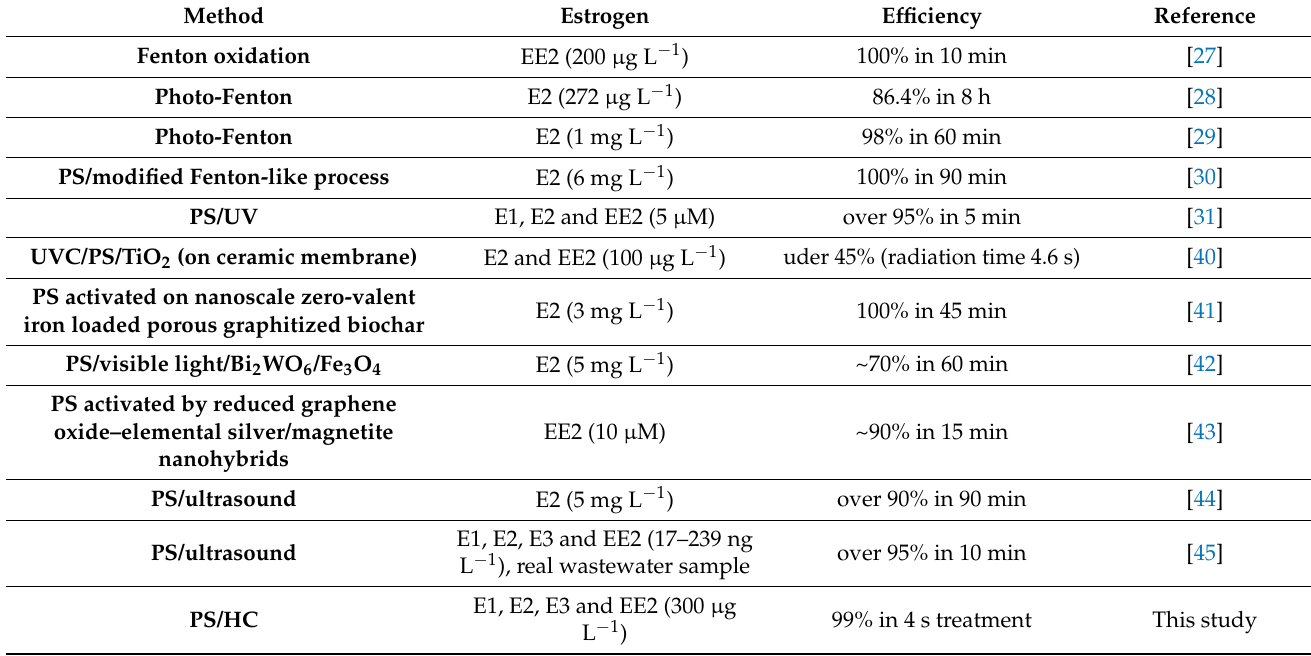
Table 3. Estrogen removal based on AOP with focus on PS-based